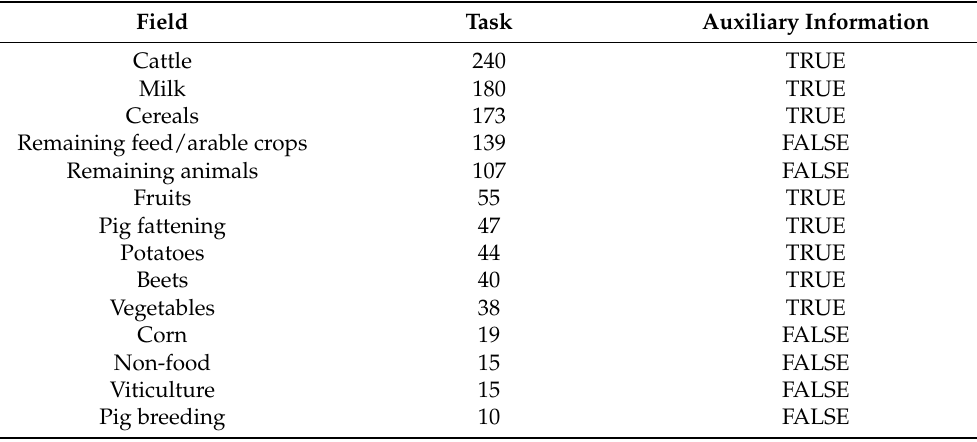
Table A2. Overview of all defined product groups. The column “Included in study” indicates if the product group was considered important and homogenous enough to be included in this study. N denotes the total available